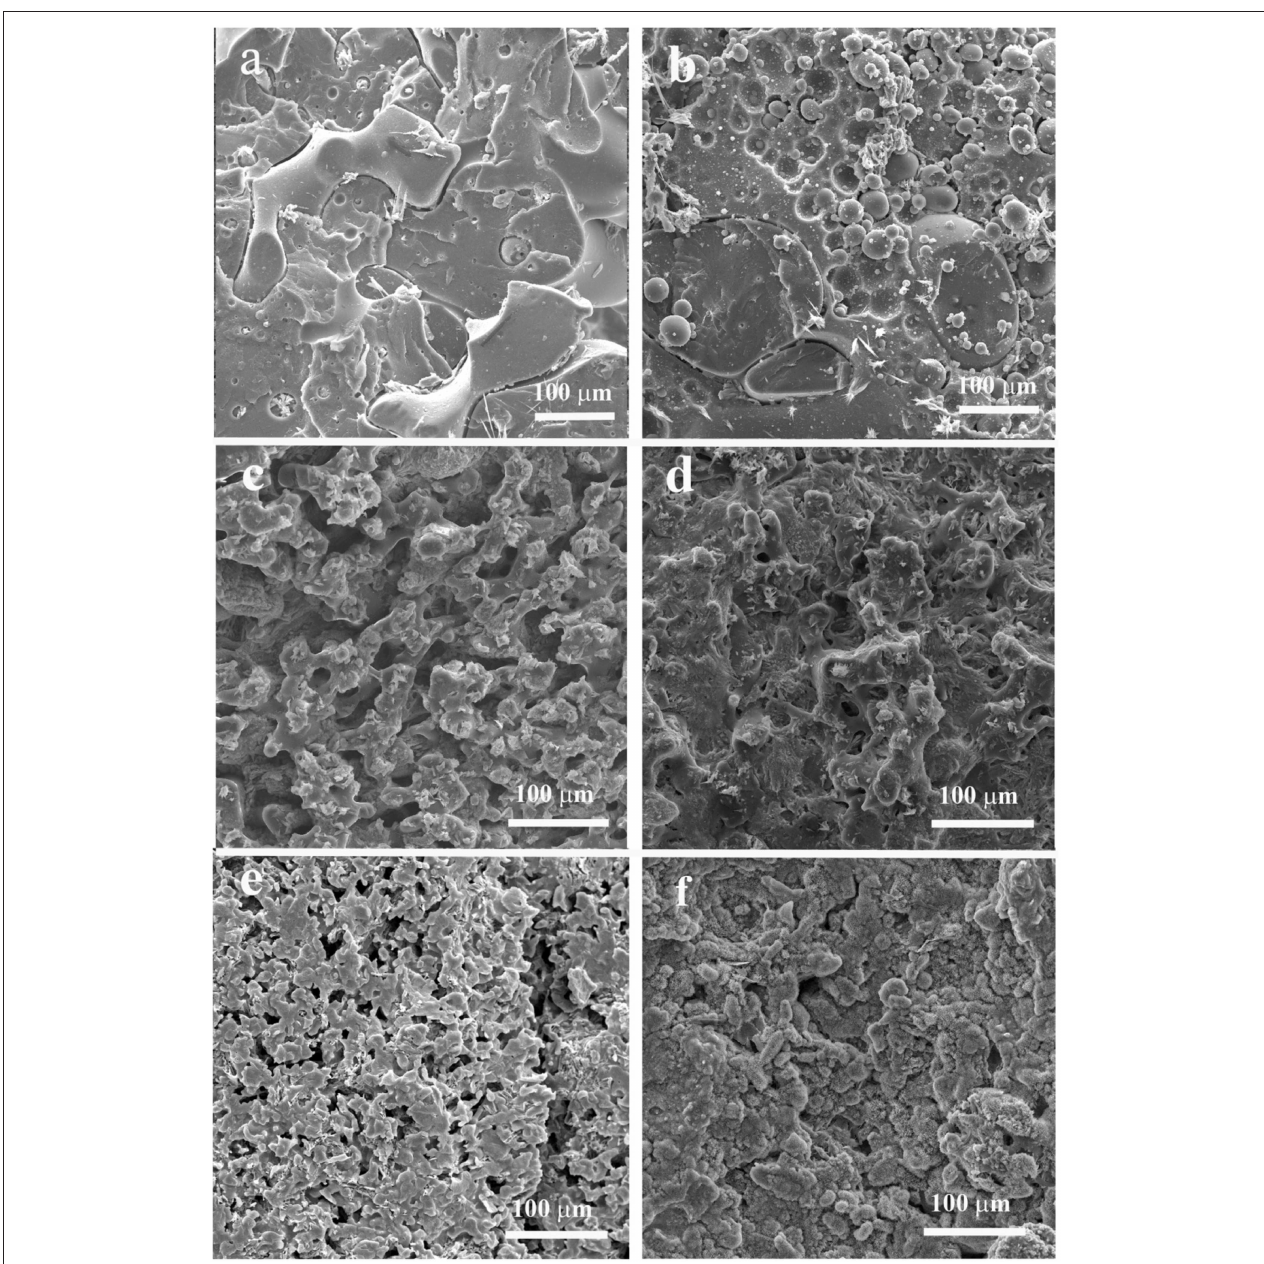
FIGURE 6 | SEM micrographs of PS/PBAT blends with (a,b) 0% of filler, (c,d) 0.66% of pCNT, and (e,f) 0.66% of IL-CNT, compression molded at 180 ◦ C (left column) and 200 ◦ C (right